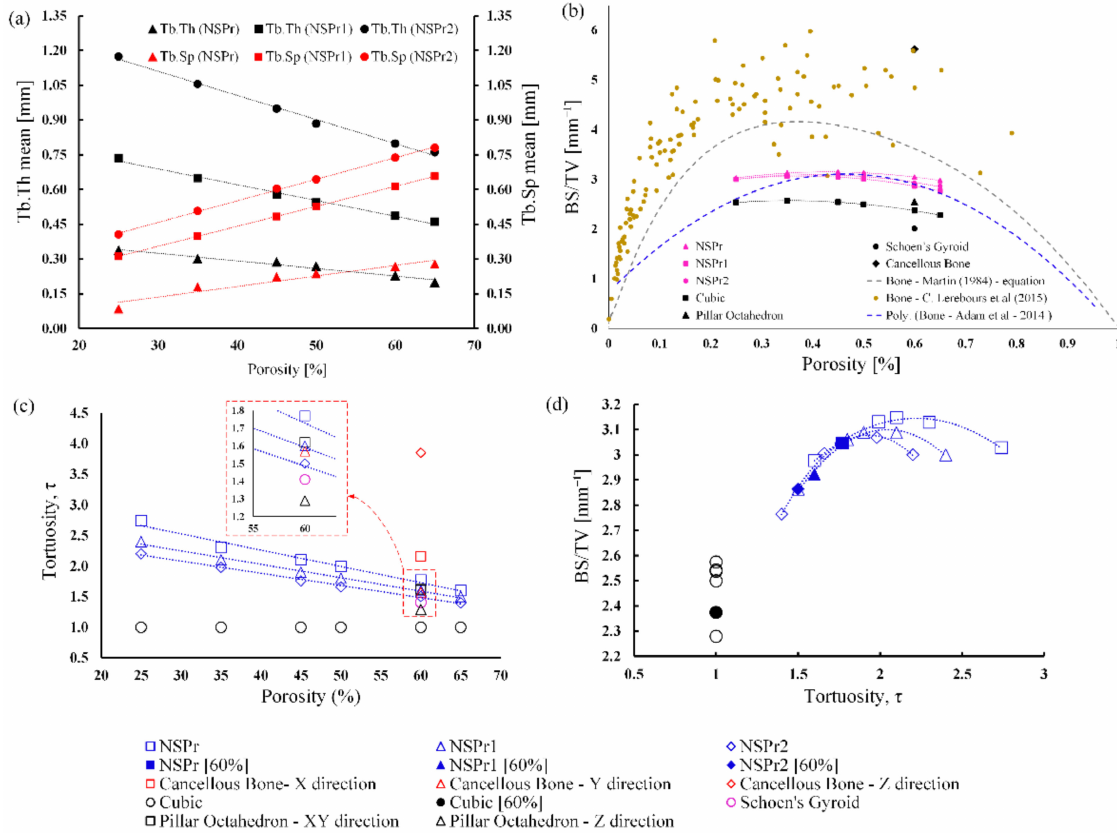
Figure 4. Results of morphological indices of porous scaffolds: ( a ) the relationship between BS/TV and porosity in the porous scaffold and cancellous bone (current study) and previous studies’ bone; ( b ) the relationship between porosity and tortuosity; ( c ) BS/TV versus porosity; and ( d ) the relation- ship between BS/TV and tortuosit